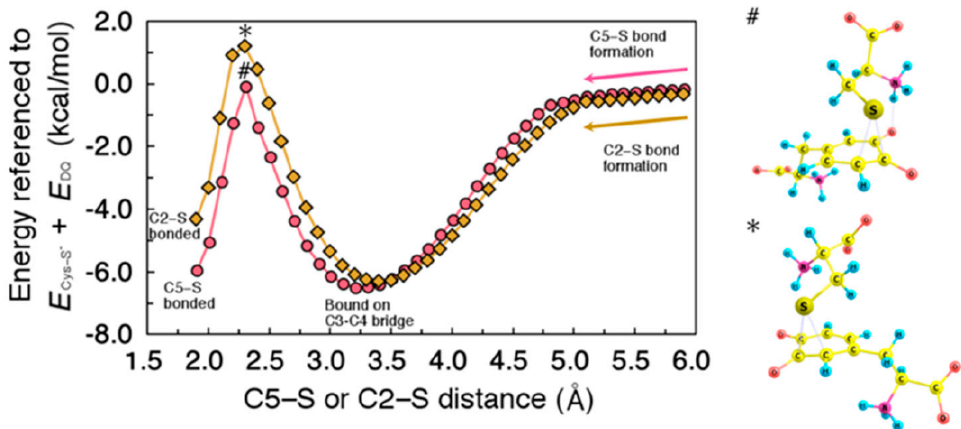
Figure 5. ( Left ) Minimum energy path for the migration of Cys–S − on 5-carbon (C5) and 2-carbon (C2), plotted as circles and diamonds, respectively. Energies were referenced to the sum of total energy of isolated systems, i.e., Cys–S − and DQ ( E Cys-S − + E DQ ). All geometrical parameters except for C5–S or C2–S distance were allowed to relax. ( Right ) Transition state structure for C5–S (#) and C2–S (*) bond